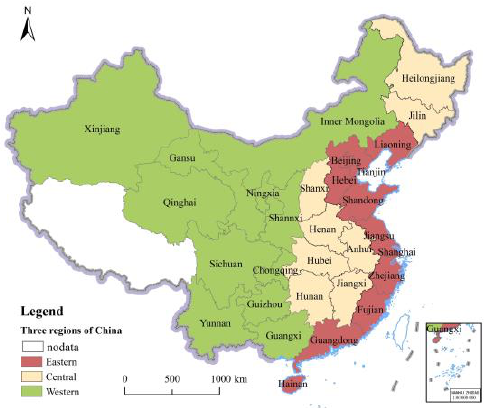
Figure 1. Spatial distribution map of the three regions in Figure 1. S patial distribution map of the three regions in China.